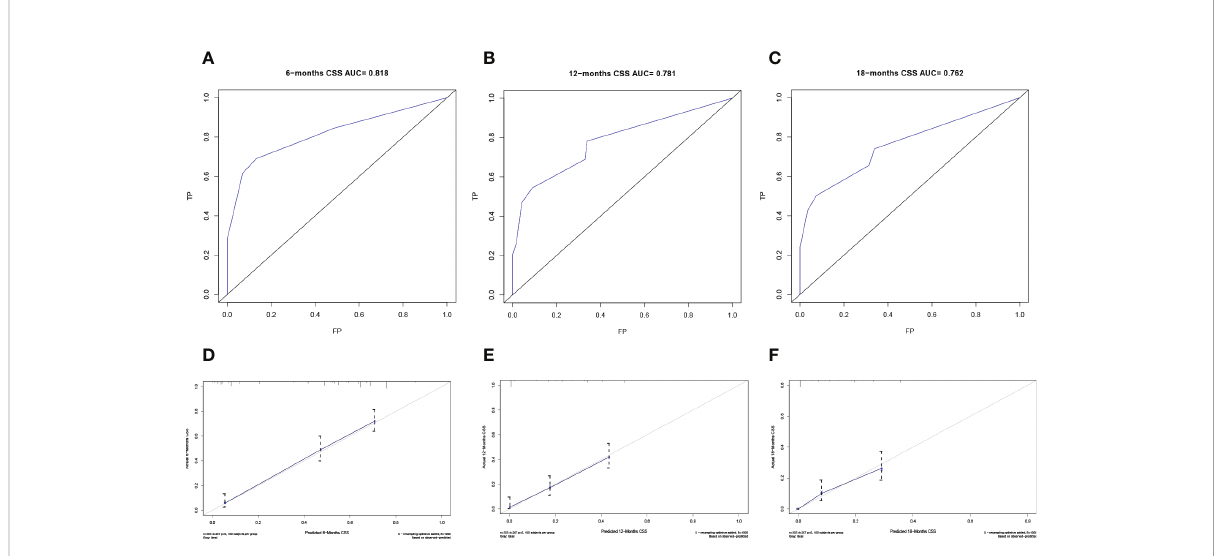
FIGURE 4 Veri fi cation of the nomogram in the training cohort. The ROC curve (A-C) and calibration curve (D-F) of the nomogram for the 6-, 12-, and 18- month CSS.